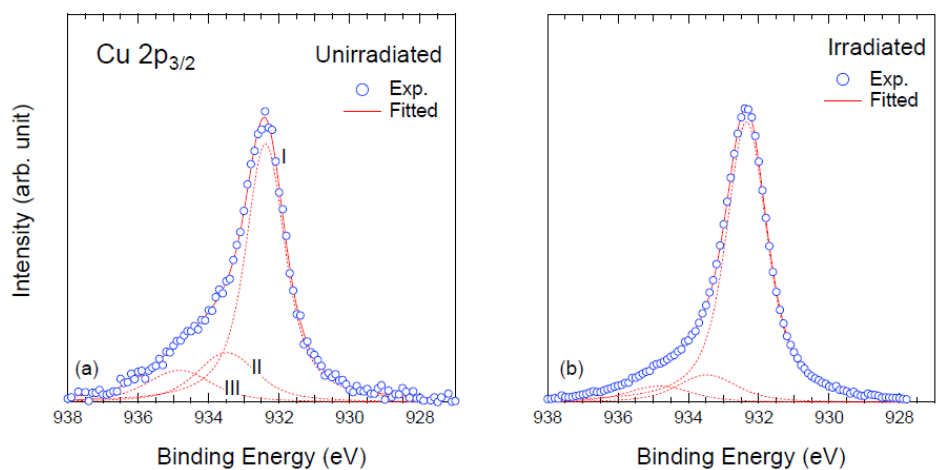
Figure 6. Detailed XPS Cu 2p3/2 core level photoemission spectra of the unirradiated ( a ) and irradiated ( b ) areas in the sample irradiated with 5 keV-Ar + ions to a fluence of 1 × 10 15 cm − 2 . Each spectrum was decomposed into three components denoted by I, II, and